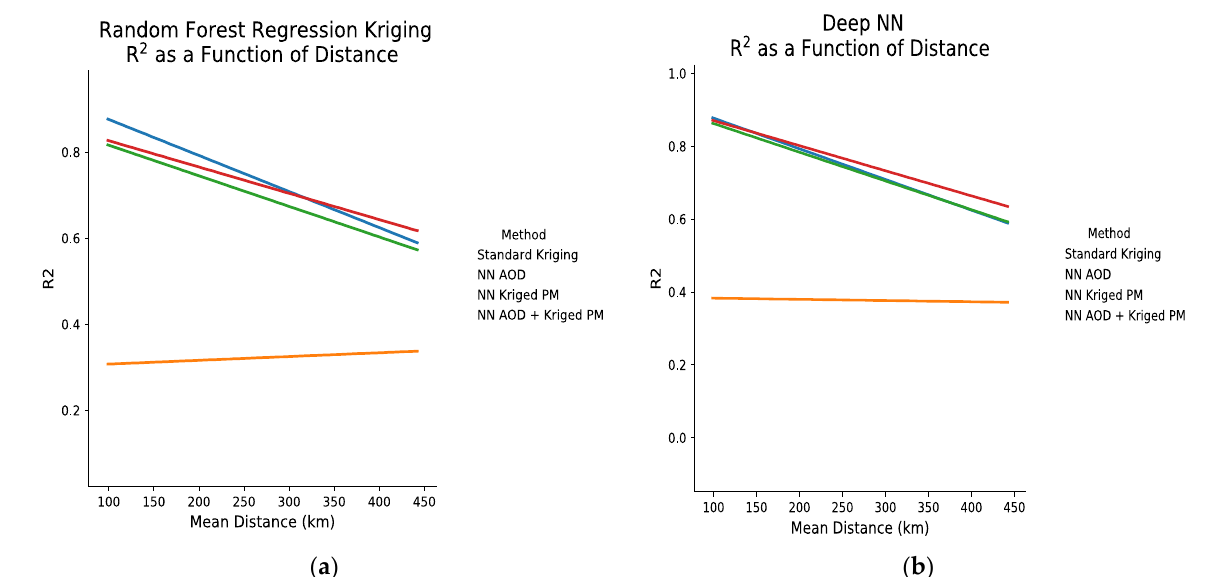
Figure 3. Simple Kriging: ( a ) Spatial interpolation over New York State (NYS) using simple Kriging, ( b ) regression score as a function of mean distance from the target location to all other locations. Regression was calculated from the hourly kriging results for all stations for 2016.